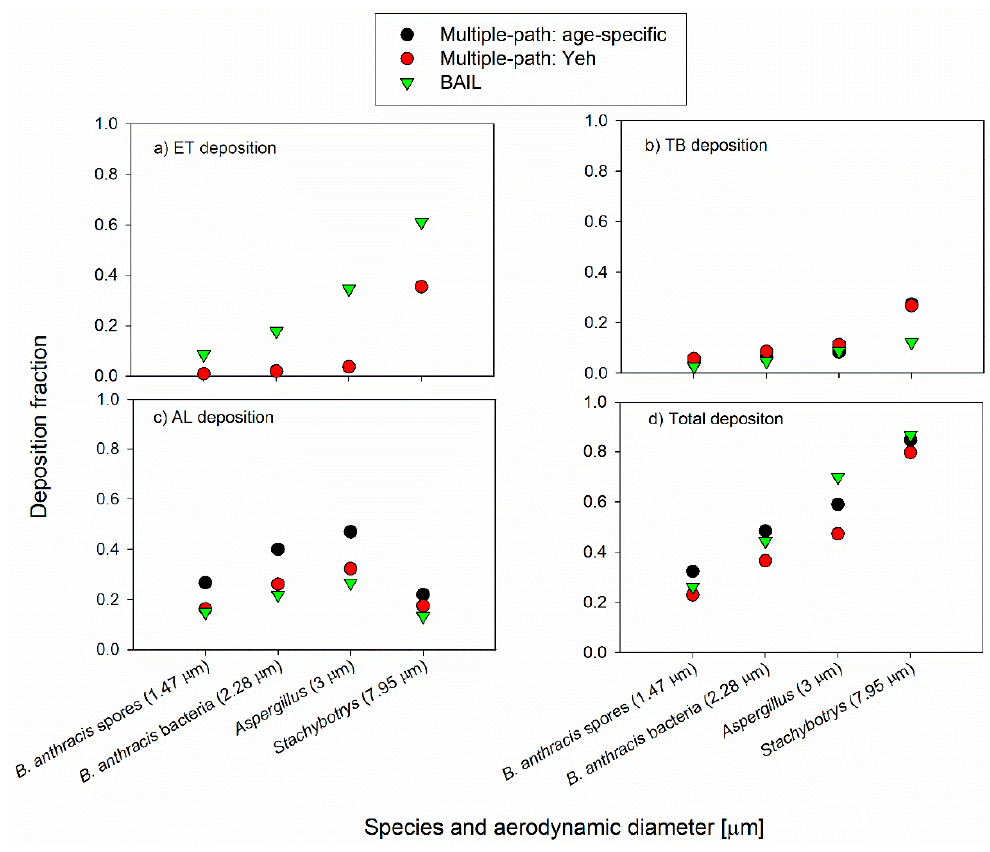
Figure 4. Regional and total deposition fraction for the mouth-breathing scenario: ( a ) ET deposition, ( b ) TB deposition, ( c ) AL deposition, and ( d ) total deposition.